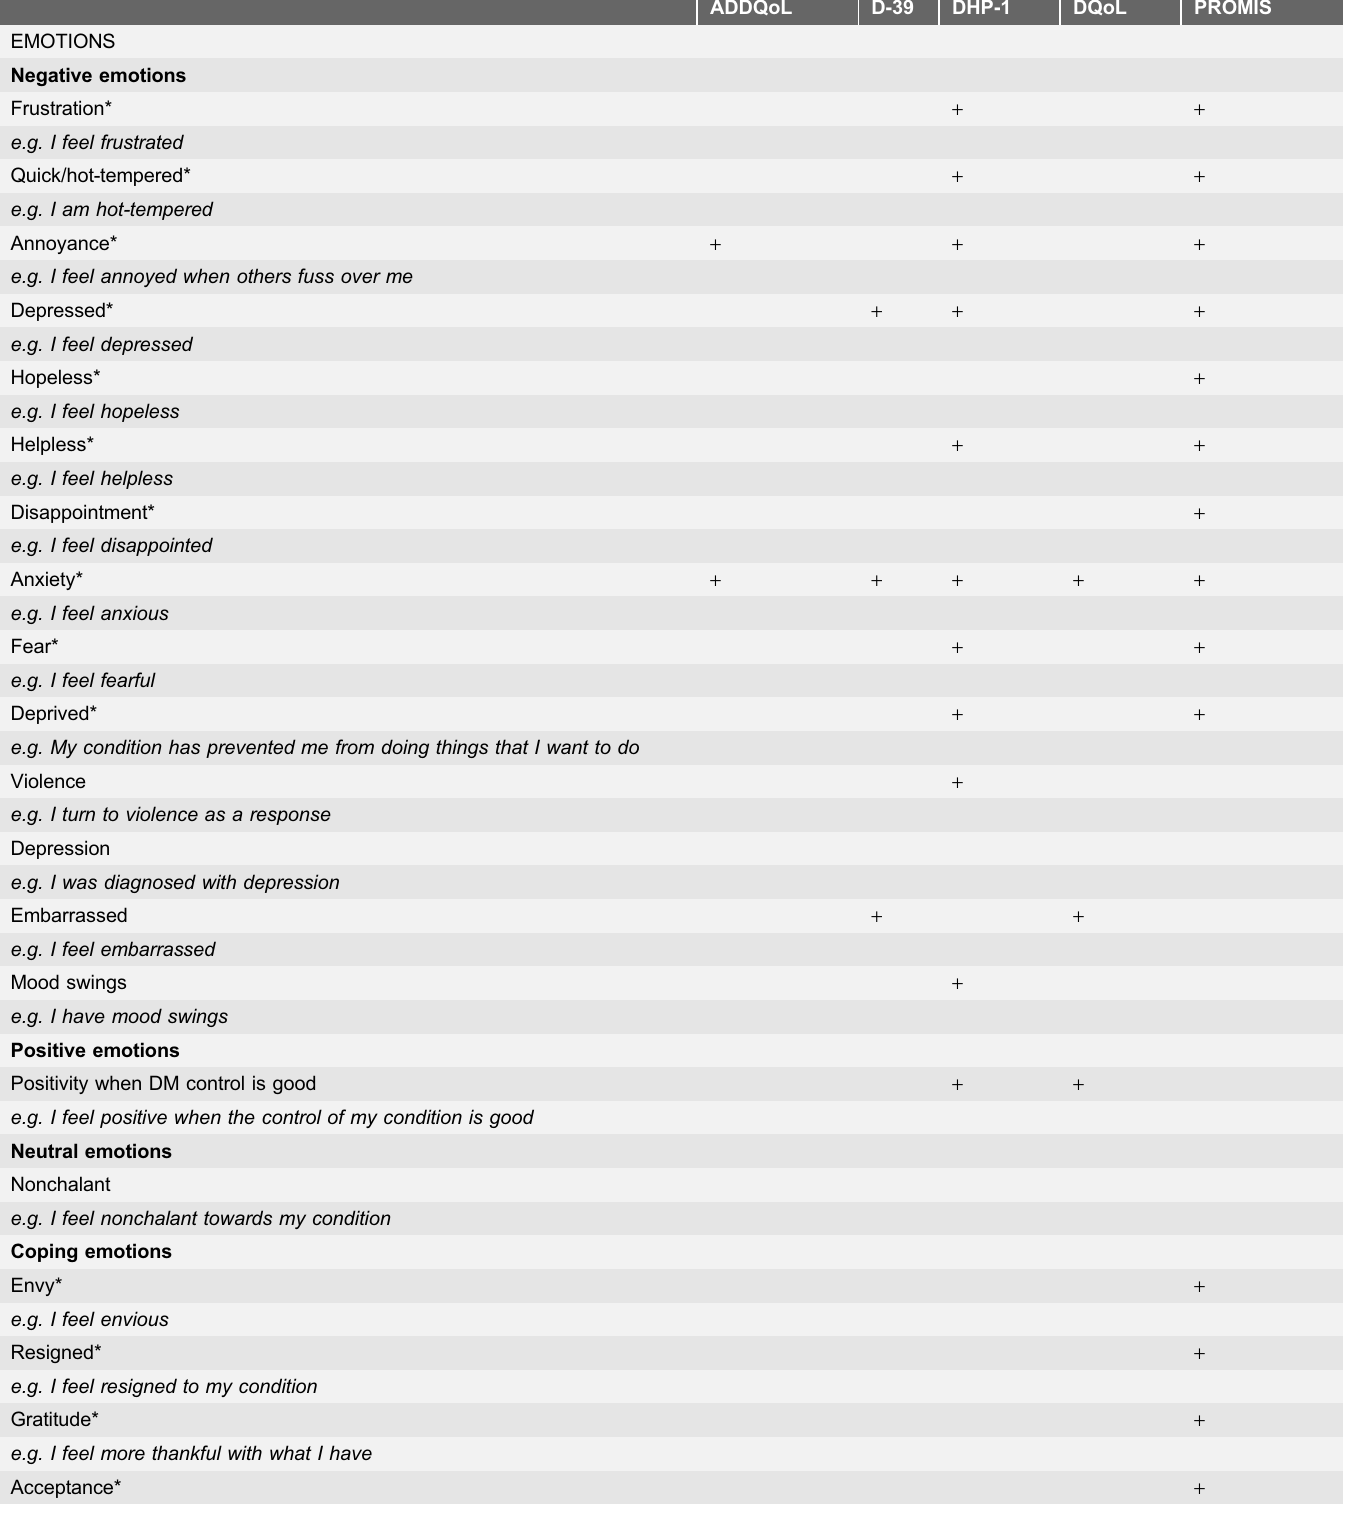
Table 2. Themes and Subthemes covered by existing DM-specific instruments and PROMIS version 1.0 and 2.0 item